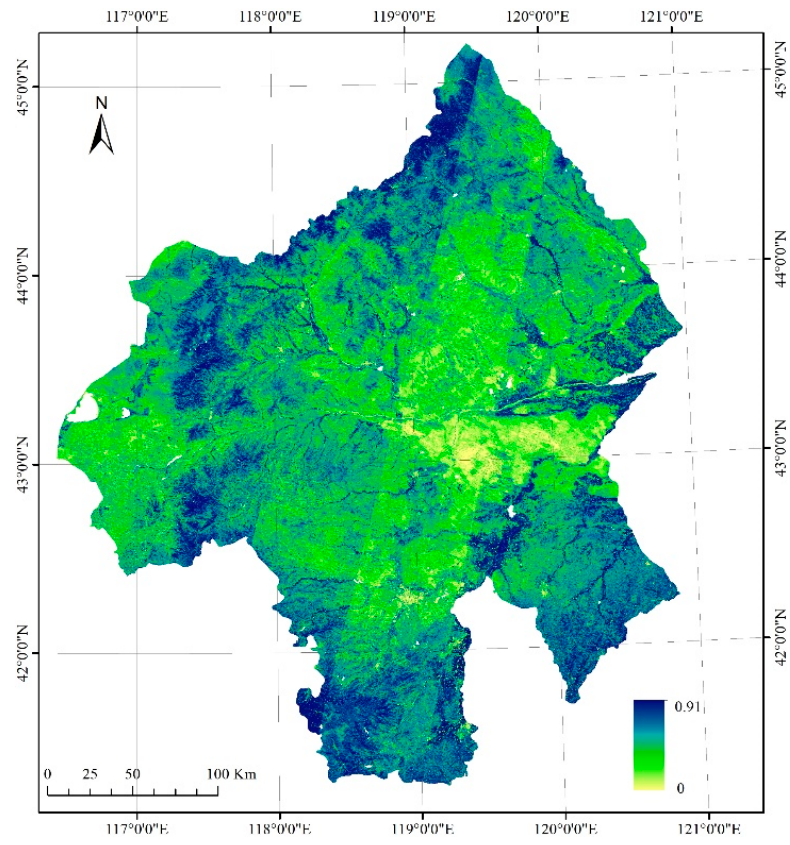
Figure 5. The canopy closure estimation results using Landsat 8 images based on BEVIs.